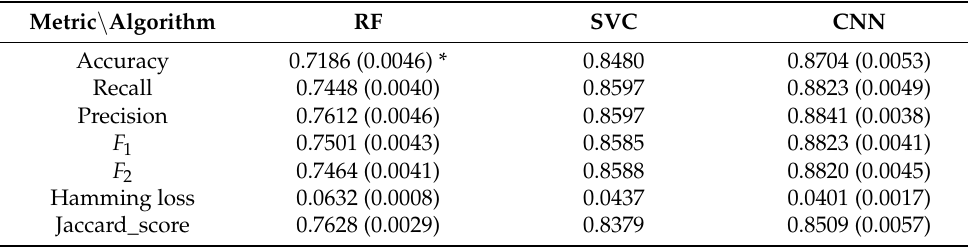
Table 7. Classification performance in experiment 4.